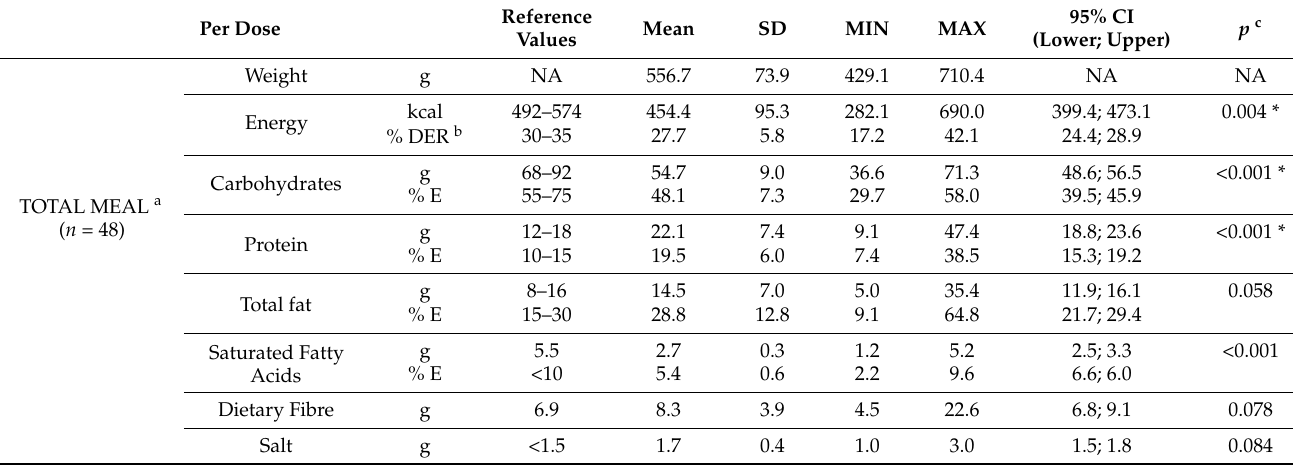
Table 3. Weight and nutritional composition of total meal of school lunches analysed and compared to the reference value. Per Dose